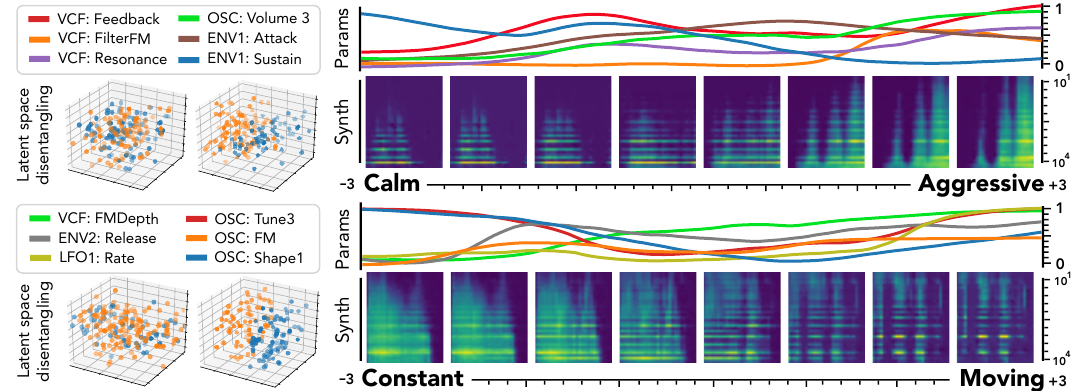
Figure 6. Semantic macro-parameters . Two latent dimensions z learned through disentangling flows for different pairs. We show the effect on the latent space ( left ) and parameters mapping p ( v when traversing these dimensions, that define smooth macro-parameters. We plot the evolution of 6 parameters with highest variance and the resulting synthesized audio ( right